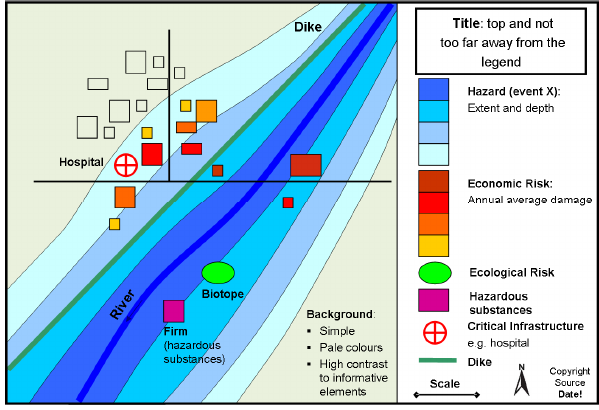
735 Figure 6: Idealised map for emergency management [Based on and adjusted from Fuchs et al. 2009] Fig. 6. Idealised map for emergency management (based on and adjusted from Fuchs et al.,